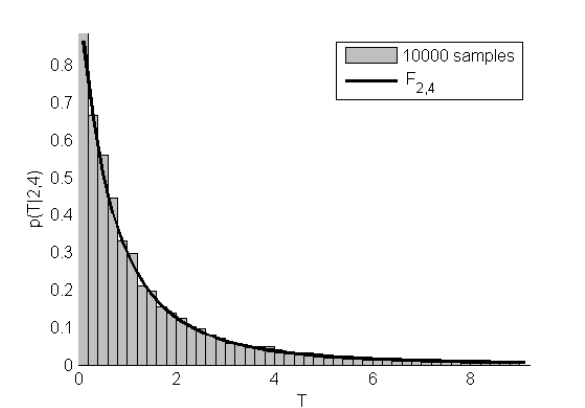
Figure 4: Distribution of the test statistic (6) for the parallelism of two planes. Two point sets with n 1 = 4 and n 2 = 6 points have been sampled 10,000